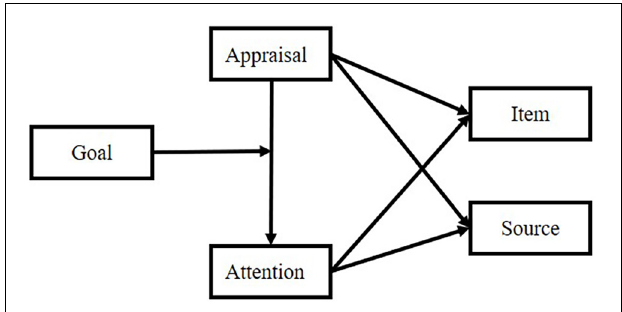
FIGURE 6 | Attention interaction between item and